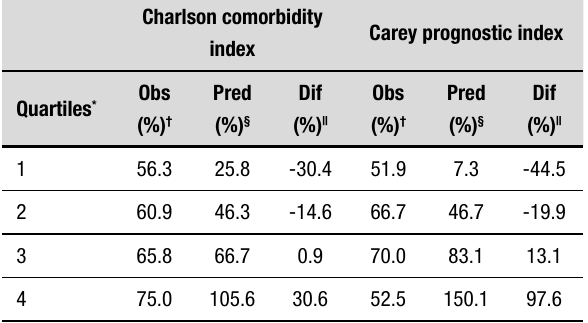
Table 3. Differences between observed and predicted 3-year mortality risks within each quartile of predicted risk of the Charlson comorbidity index and the Carey prognostic